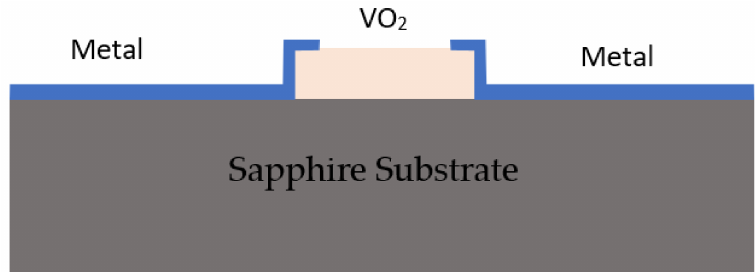
Figure 11. Cross-sectional view of Electrically triggered VO 2 based RF